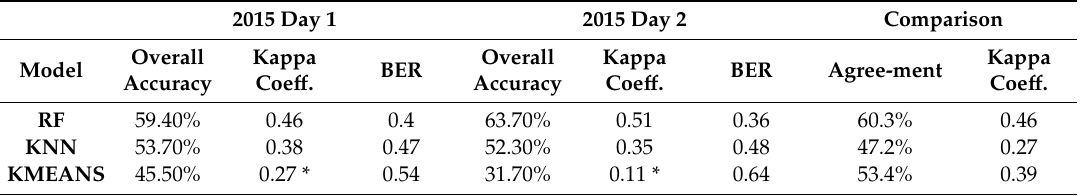
Table 7. Performance comparison of Random Forest (RF), k-nearest neighbours (KNN), and k-means (KMEANS) classifications on consecutive days in 2015.